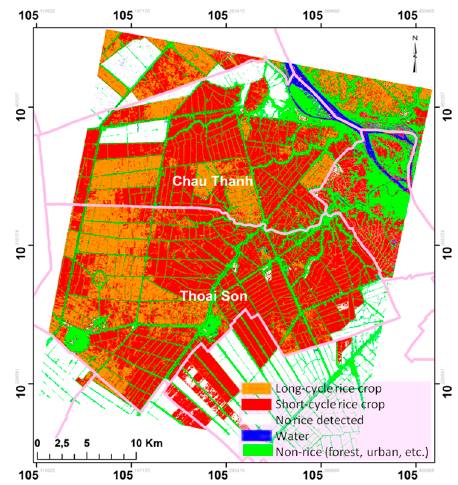
Figure 13. Rice varieties map using polarization ratio method. Orange: long-cycle rice crop (30.3%); red: short-cycle rice crop (69.7%); Blue: Water; Green: built areas and trees; White: no rice detected.